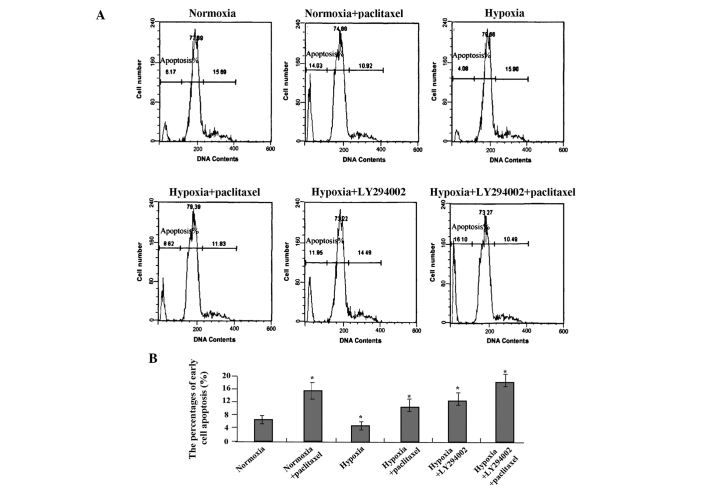
Effects of LY294002 and/or paclitaxel on cell apoptosis. (A) Cell apoptosis was measured by flow cytometry analysis using propidium iodide staining. (B) Following treatment with LY294002 and/or paclitaxel for 24 h, LY294002 combined with paclitaxel significantly increased the percentage of early cell apoptosis compared with the single treatment of LY294002 or paclitaxel (each P<0.01). LY294002 or paclitaxel also improved the percentage of early cell apoptosis compared with the hypoxia group. *P<0.01 compared with normoxia.